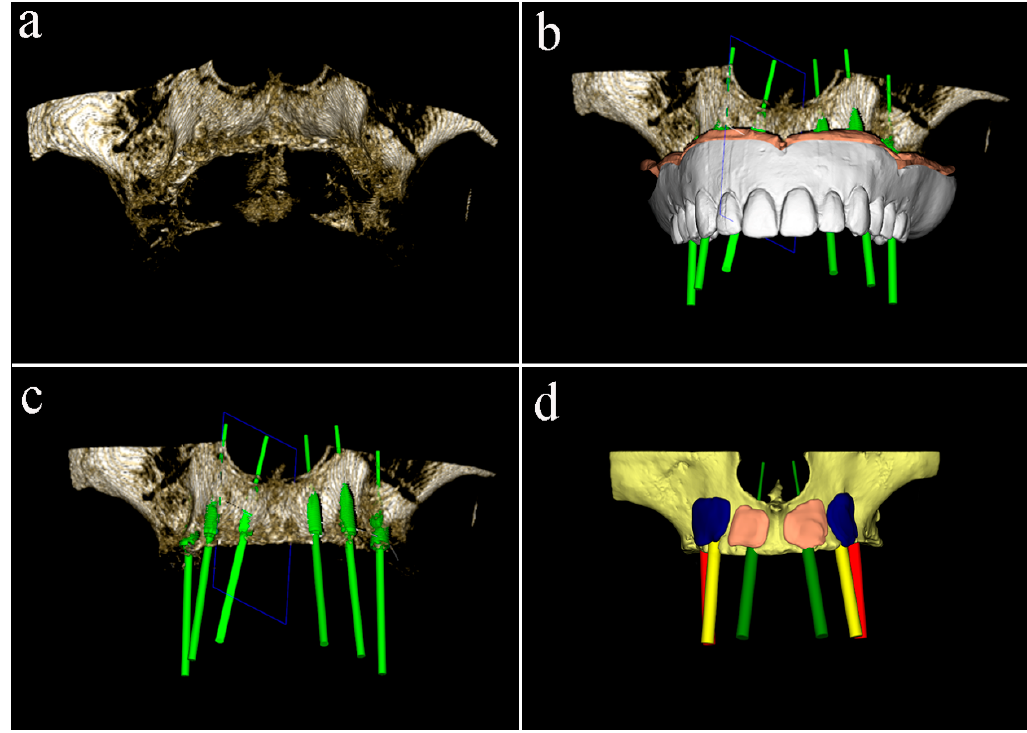
Figure 1. Diagnosis and treatment planning: ( a ) pre-operative cone-beam computed tomography (CBCT); ( b ) virtually planned prosthetic-driven position of the implants; ( c ) bone defects at planned implant sites; ( d ) virtual model of the graft blocks.